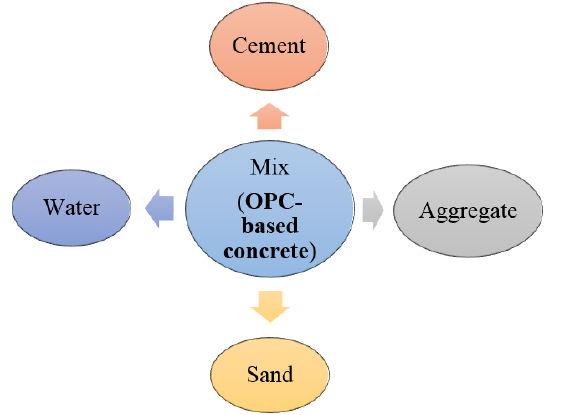
Figure 3. Schematic representation of the ingredients of OPC concrete.